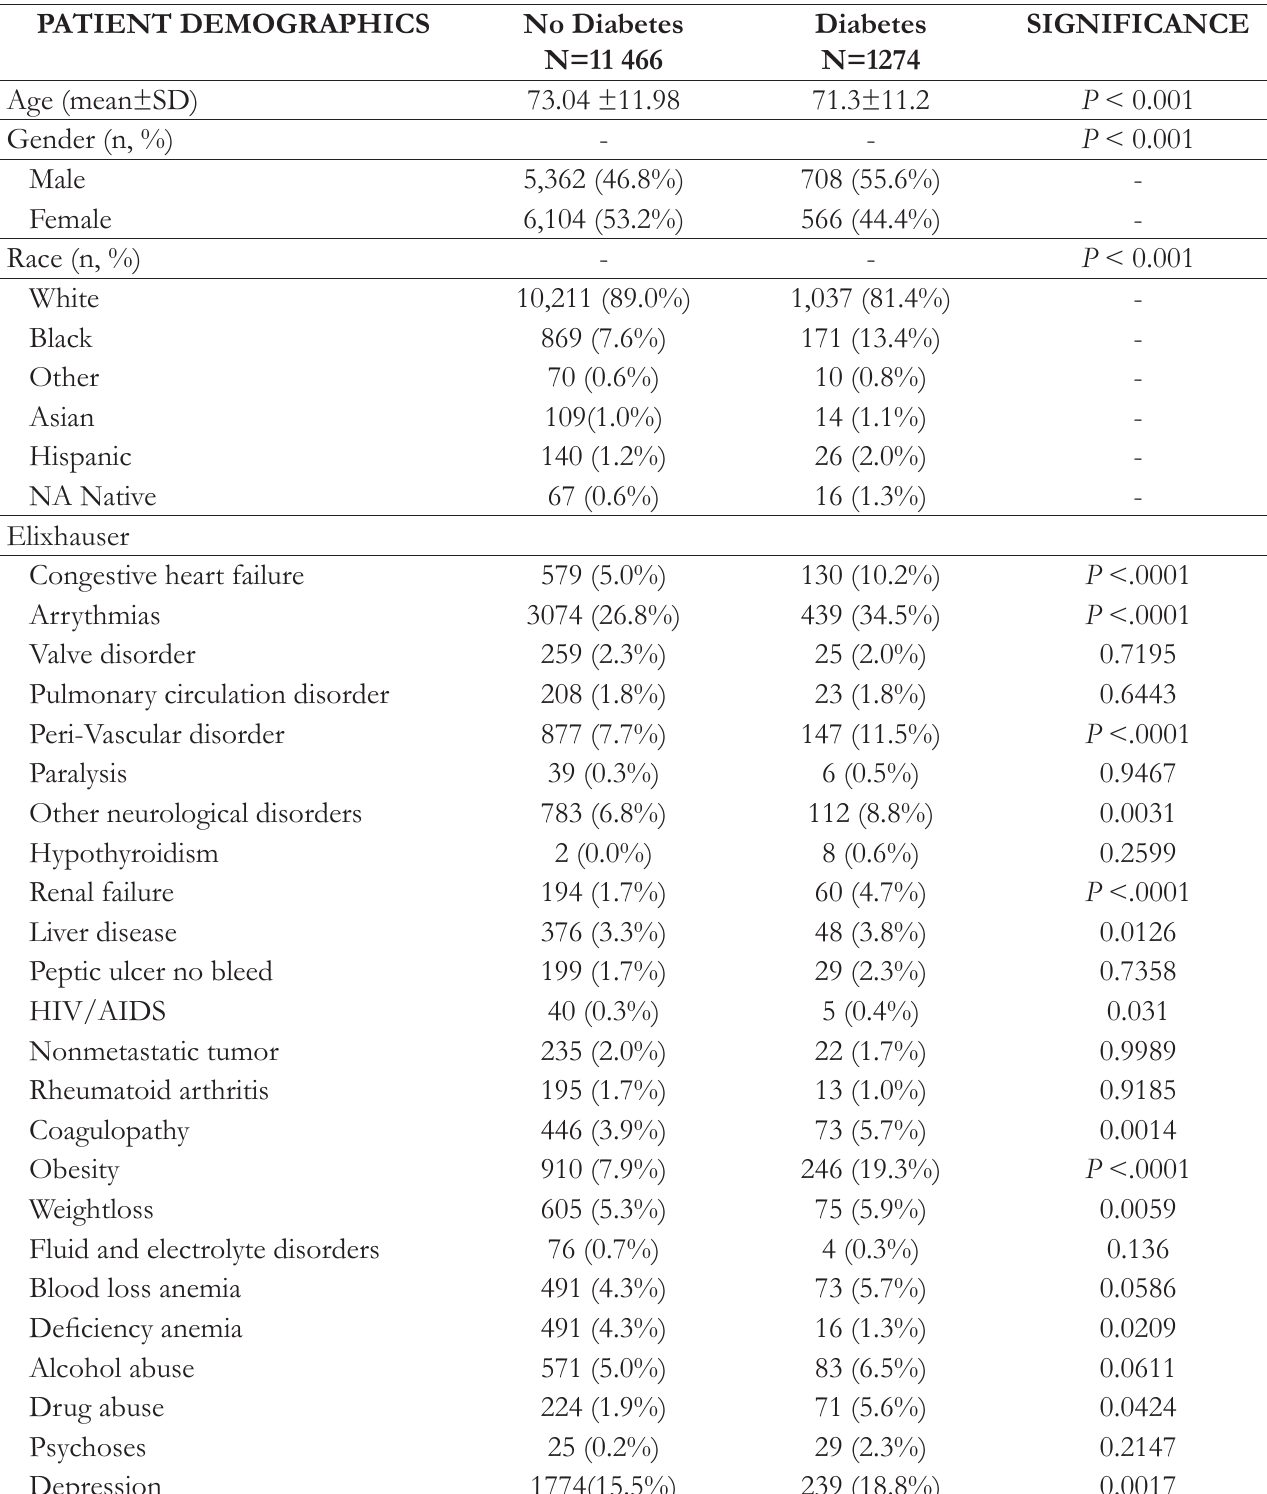
Table 1. Baseline Characteristics Prior to